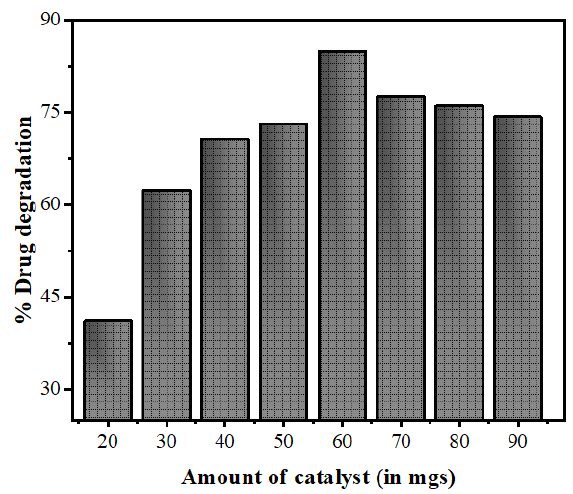
Figure 13. Effects of variation of the amount of catalyst Mn:ZnSQDs on the photocatalytic degradation of NOFX under optimal conditions (25 mL of drug, pH 10, 60 min irradiation).